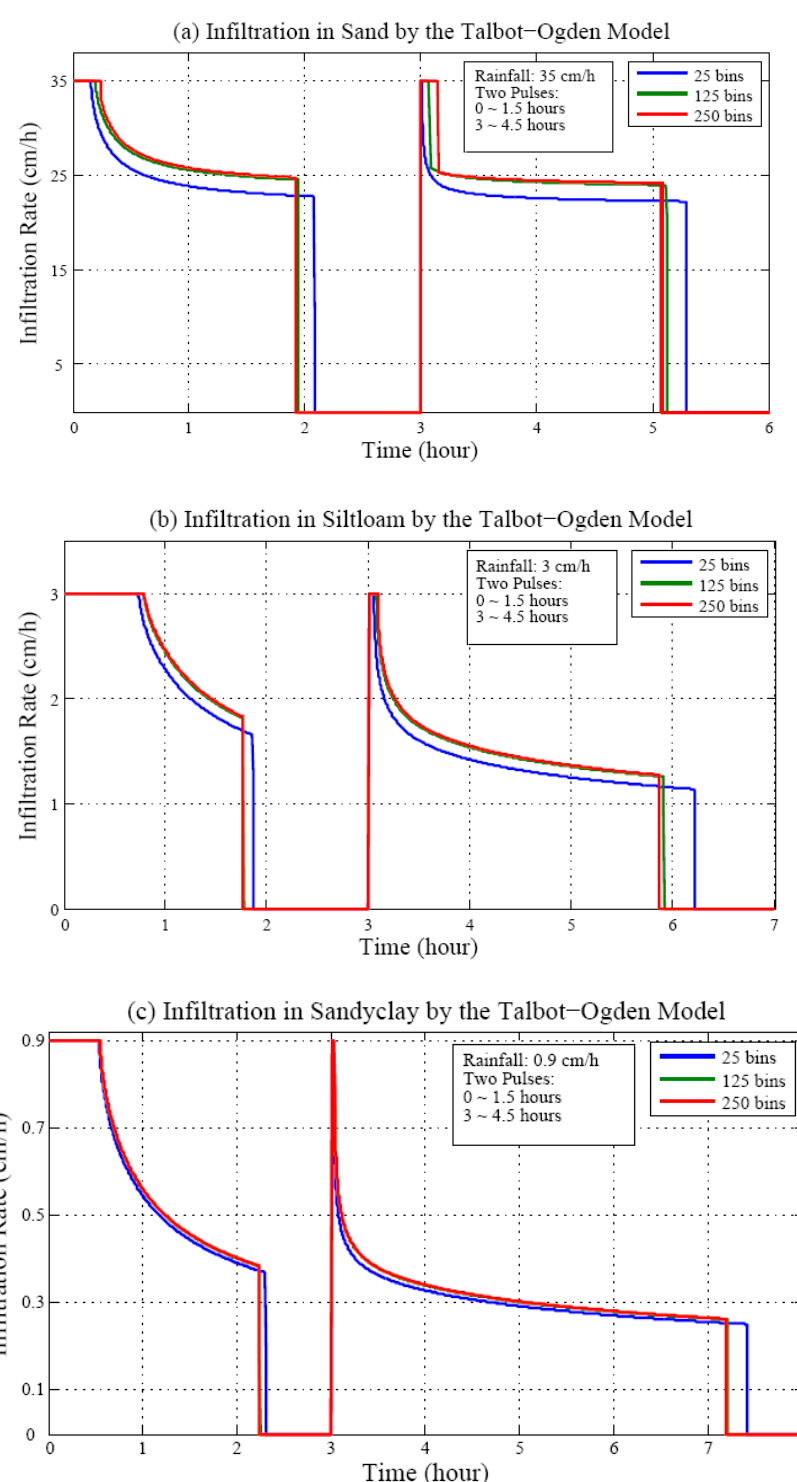
Figure 9. Comparison of infiltration rates in ( a ) sand, ( b ) silt loam, and ( c ) sandy clay using different numbers of numbers of bins.